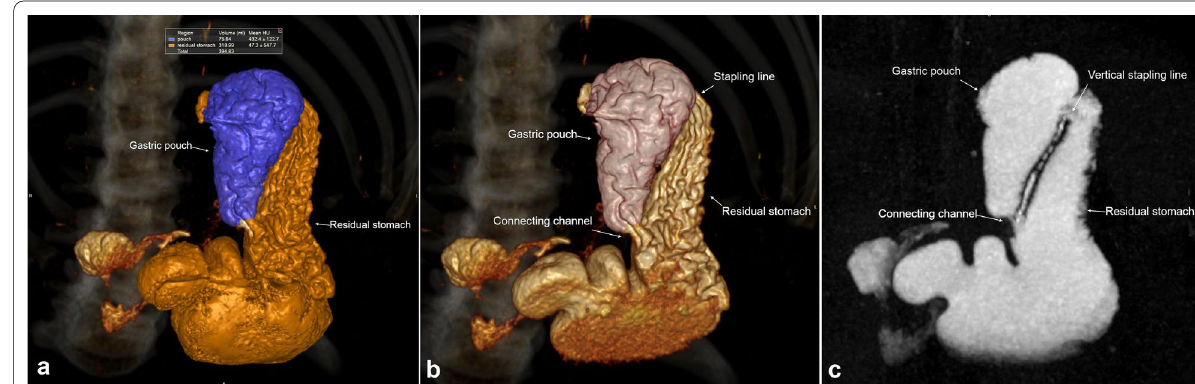
Fig. 2 Gastric pouch dilatation after butterfly gastroplasty with recurrent weight gain. CT gastric volumetry image ( a ) clearly delineate gastric pouch (blue color) with its volume measuring 76 ml. 3D volume rendered image ( b ) and MIP reconstruction ( c ) demonstrates the anatomical changes including intact stapling line and widely patent connecting channel (stoma)